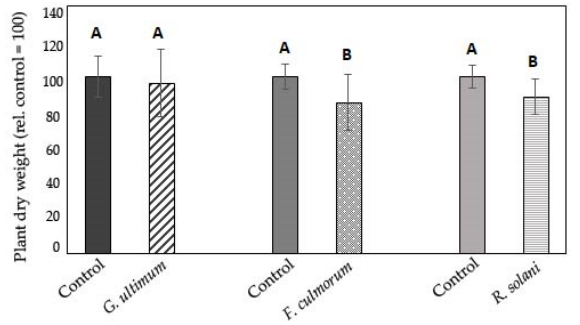
Figure 4. Development of maize seedlings transferred from non-inoculated potting substrate onto non-inoculated potting substrate (controls), or from non-inoculated potting substrate onto potting substrate inoculated with Globisporangium ultimum , Fusarium culmorum or Rhizoctonia solani . Means and standard deviation of five pots per treatment with five maize seeds each. Different letters above bars indicate statistically significant differences between the respective control and pathogen (GLMM; p < 0.05) based on absolute numbers of plant dry weight per pot.